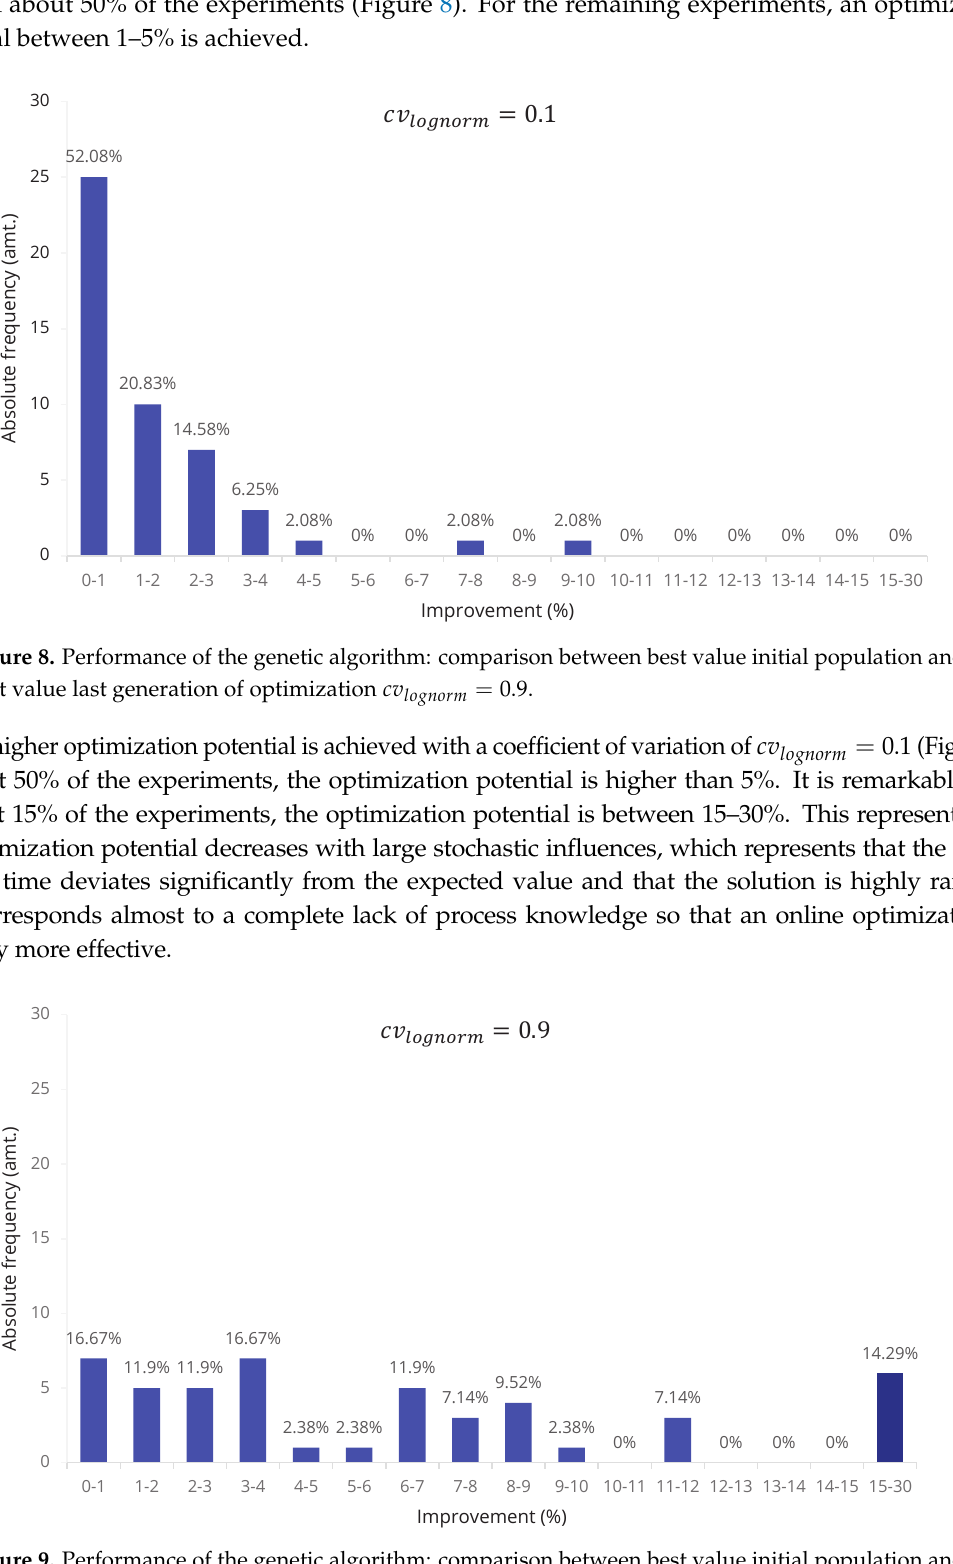
Figure 9. Performance of the genetic algorithm: comparison between best value initial population and best value last generation of optimization cv lognorm =